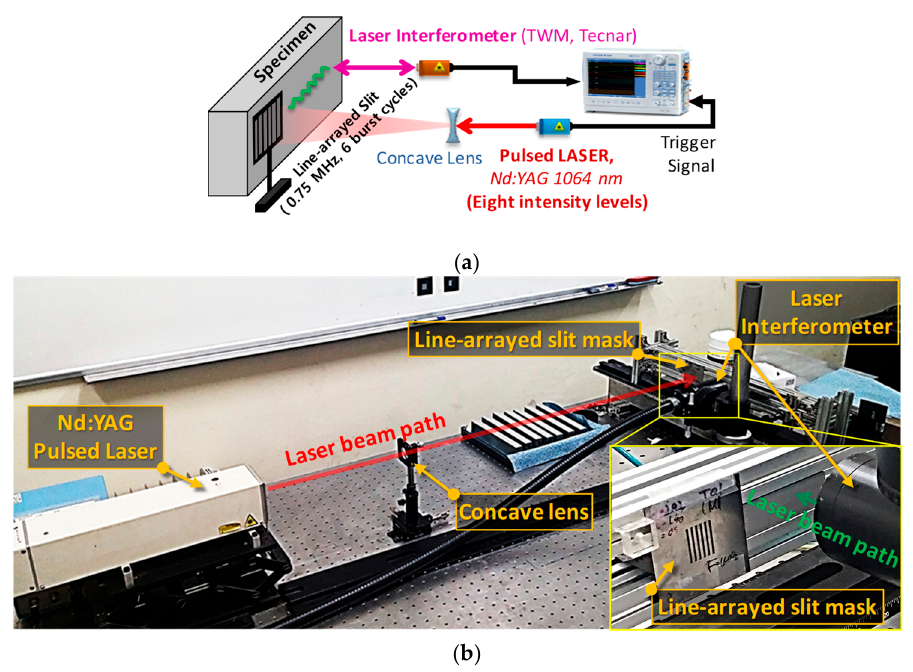
Figure 6. The experimental setup for acoustic nonlinearity measurement using the laser-generated SAW; ( a ) a schematic diagram of the experimental setup; ( b ) a picture of the experimental setup.